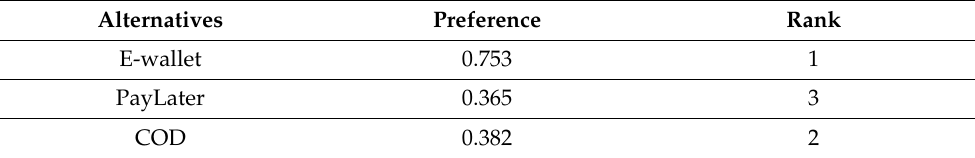
Table 4. Rank of Payment Method Collaboration using